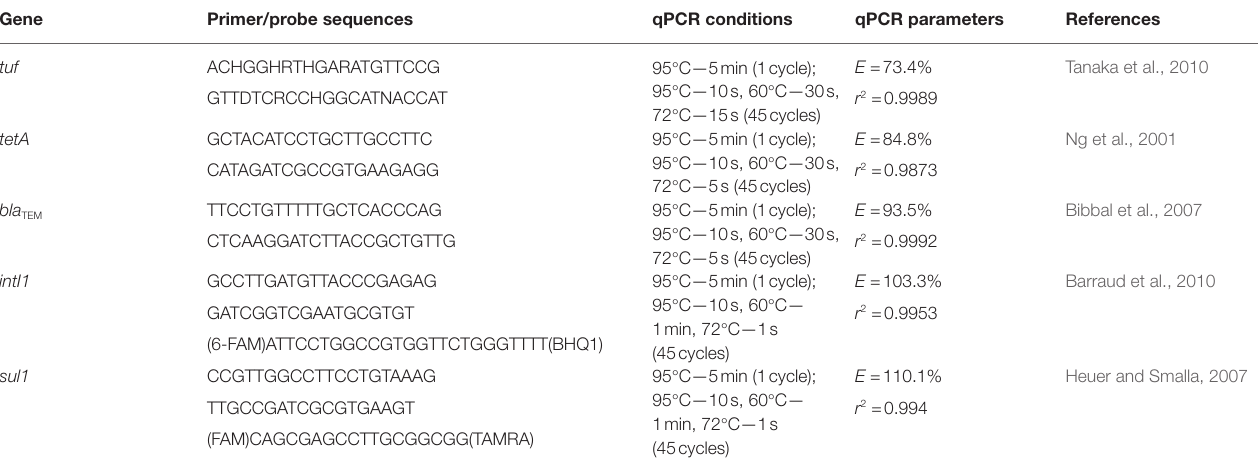
TABLE 1 | Primer and probe sequences and conditions associated to the quantitative PCR (qPCR) used in this